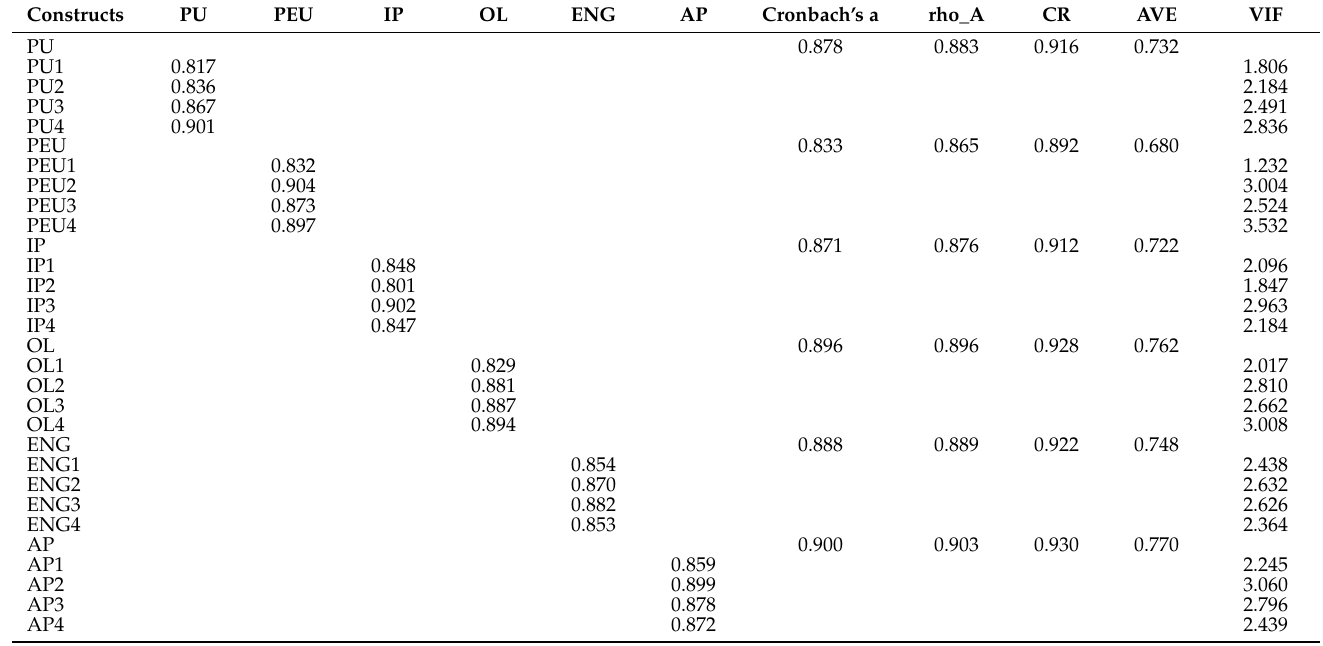
Table 2. Factor loadings, Cronbach’s alpha, rho_A, CR, AVE, and